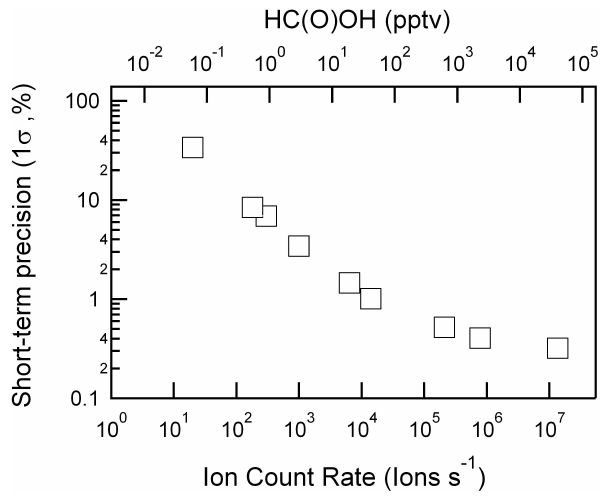
Fig. 7. Dependence of instrument short-term precision on the mea- sured ion count rate.